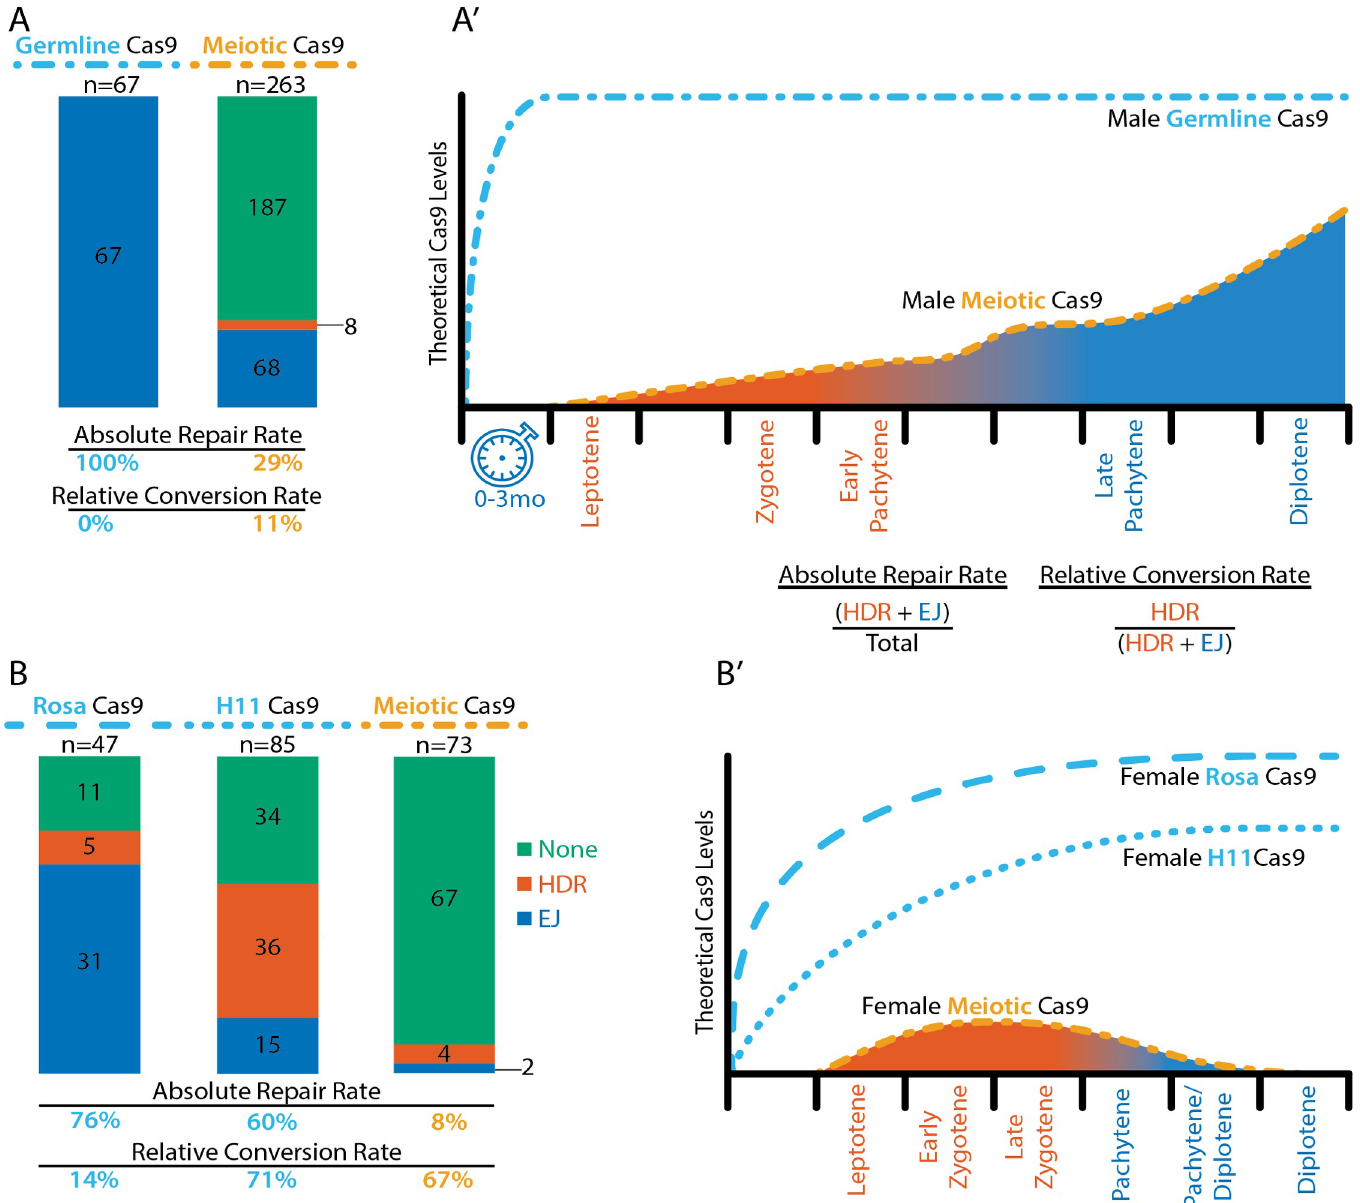
Fig 3. Comparisons of outcomes of each genetic strategy with models of theoretical Cas9 levels and timing with respect to DSB repair type during meiosis I. (A) “Germline” Cas9 offspring of males for the combined outcomes of Vasa-Cre;Rosa- and H11-LSLCas9, data sourced from [1], and “Meiotic” Cas9 offspring of males from Fig 2D. (B) “Germline” Cas9 offspring of females of each of the Vasa-Cre;Rosa- and H11-LSLCas9 “Germline” strategies and “Meiotic” Cas9 offspring of females from Fig 2D. Each bar graph represents the sum of repair types across all Tyr ch recipient chromosomes in each strategy. Green, no cut or in frame repair; Red, interchromosomal HDR; Blue, EJ. Below each bar graph are the absolute repair rates and relative conversion rates, as defined by the equations shown. (A’ and B’) Models of theoretical Cas9 levels across the range of time relevant to gene conversion. Each hash on the x-axis represents approximately 1 day. Leptotene in the female occurs at about E15.5 and initiates sporadically in maturing males. The orange line represents the theorized relative Cas9 level inferred from RT-qPCR levels [21] and our eGFP IF ovaries and testes. The blue dotted line represents the theoretical expression of Cas9 under a strong CMV promoter and initiated in the germline by expression of Vasa-Cre in spermatogonia and oogonia. The blue dotted line plateaus faster in the male than in the female because many months are represented in the interval (clock) before meiosis is initiated in the male germline. The area under the curve and their respective stages are colored red (HDR) or blue (EJ) to demonstrate the inferred preference for the respective repair type at the time of the cut [18]. The relative shaded area of each color (and thus repair type) under each curve is roughly proportional to the observed “Relative Conversion Rate” shown below the respective “Meiosis” bar graphs in (A) and (B). DSB, double-strand DNA break; EJ, end joining; HDR, homology-directed repair.